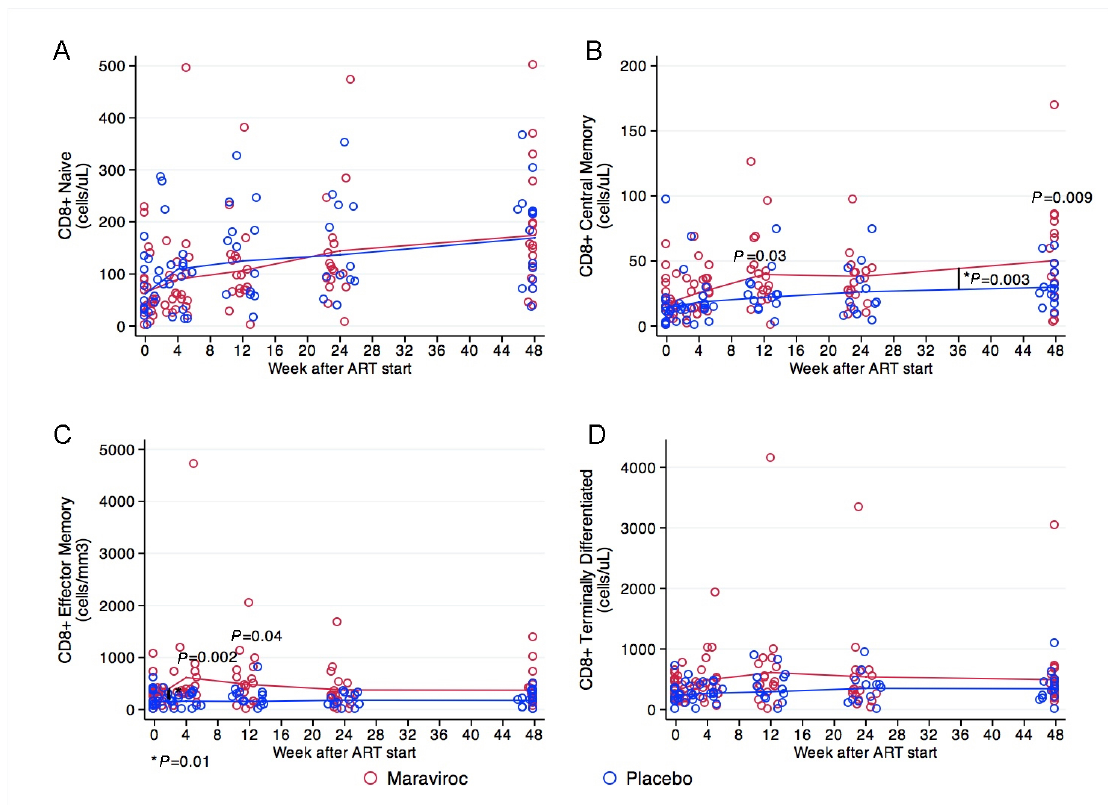
Figure 4. CD8+ cell maturation subsets at baseline and weeks 4, 12, 24, and 48. (A) CD8 naive cell counts steadily increased in both treatment groups. (B) Participants receiving maraviroc had a greater increase in CD8+ central memory cells during the first 12 weeks of ART in comparison to those receiving placebo. After reaching a plateau between weeks 12 and 24 in both groups, participants receiving maraviroc had greater increases in this subset, and had significantly higher counts at weeks 48. (C) Participants receiving maraviroc showed a sharp increase in CD8+ effector memory cells during the first 4 weeks of treatment, but no significant changes were observed subsequently in both groups. The CD8+ effector memory cells were significantly higher at weeks 4 and 12 in participants receiving maraviroc. (D) Terminally differenti- ated CD8+ cells increased in the maraviroc recipients over the 48 weeks, mostly during the first 12 weeks after treatment initiation, but no statistically significant differences between treatment arms were observed. Note that the scale for the Y-axis differs among the panels. Comparisons of mean values at each measure- ment between treatment arms are indicated when P <0.05. Comparisons in the rate of change between 1 time point to the next are indicated by a vertical line and asterisk when P < 0.05. The P-values were derived from mixed linear models using linear combination of coefficients after model